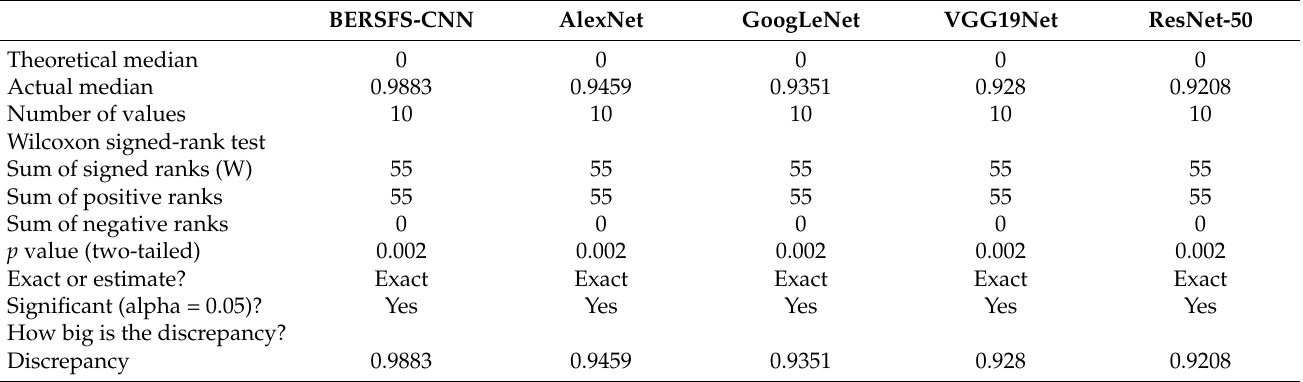
Table 9. Results for the Wilcoxon signed-rank test of the BERSFS-CNN model and deep learning